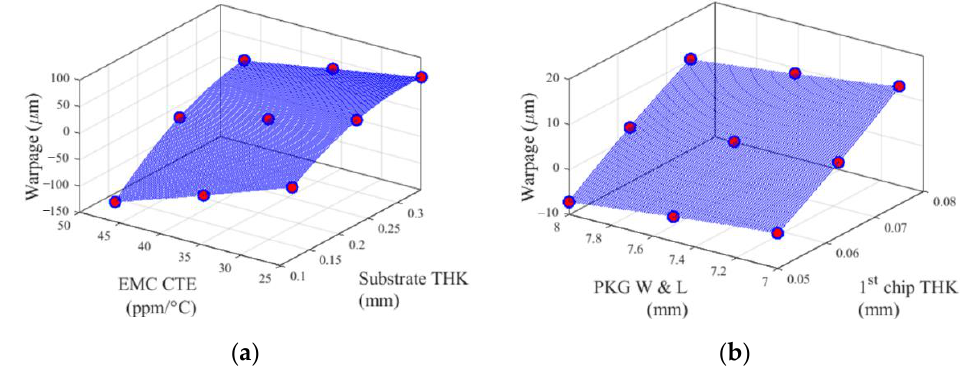
Figure 6. 2D performance functions of two pairs of design variables: ( a ) substrate thickness and EMC CTE, and ( b ) package width and length and 1st chip thickness.